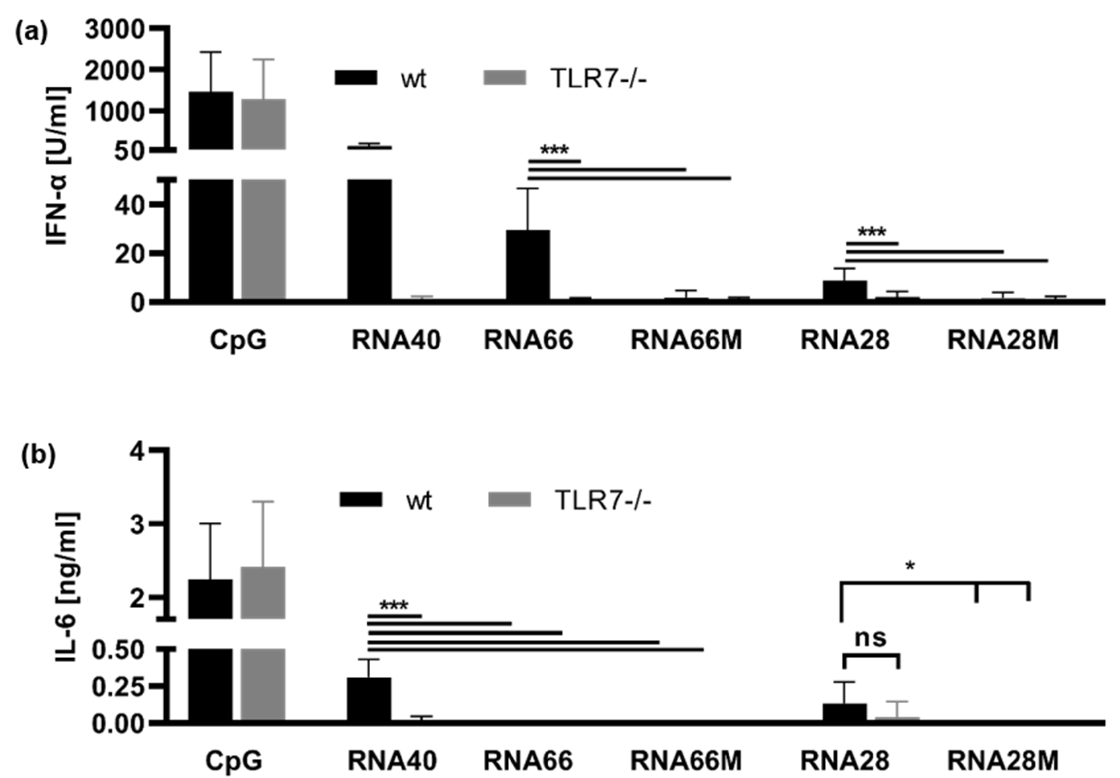
Figure 4. Methylation by 2′-O-ribose of different sequences prevents TLR7 activation. FLT3L DCs from wt or Tlr7 −/− mice were stimulated with 1 µM CpG ODN 2216, 5 µg/mL RNA40, and RNA66 derivatives or RNA28 derivatives at a final concentration of 10 µg/mL. Supernatants were